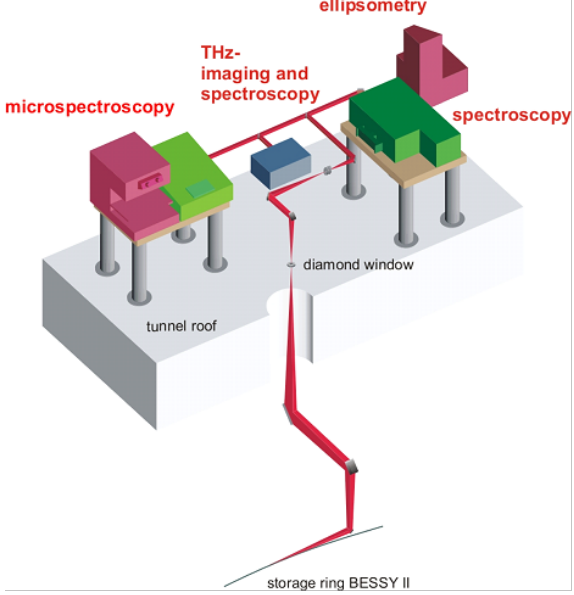
Figure 1: Schematic of the optical layout of the IRIS beamline.